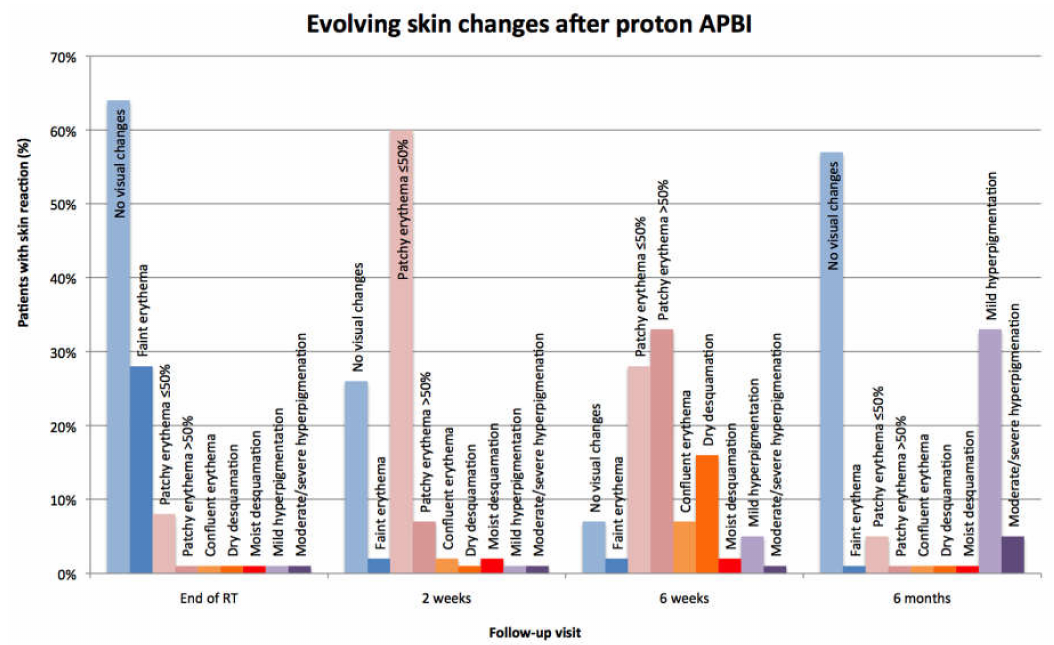
Figure 2. Evolving skin effects of proton accelerated partial breast irradiation (APBI) at the end of radiotherapy, two weeks, six weeks, and six months. APBI, accelerated partial breast irradiation. Skin reactions increased from week two to week six of follow-up, when the peak reaction was documented. Almost all patients developed visual skin changes at this time (93%), with patchy erythema in >50% of the treated skin area and ≤ 50% of the treated skin area in 33% and 28% of